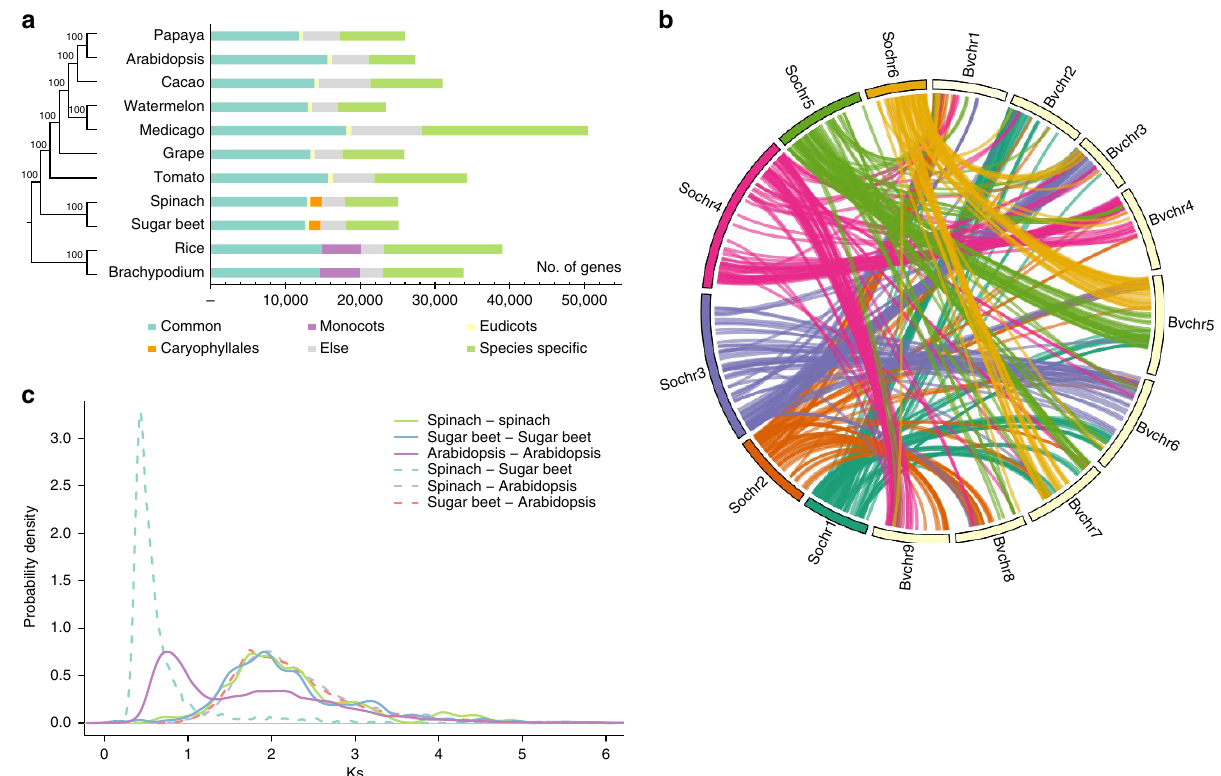
Figure 2 | Comparative genomic analysis among spinach and other plant species. ( a ) Phylogenetic relationship and gene clusters of 11 plant species. A maximum parsimony (MP) species tree (left) was constructed using protein sequences of the 2,047 single-copy genes. Bars (right) represent the number of genes in different categories for each species. Common: genes that are found in at least 10 of the 11 species. Monocots: genes that are only found in the two monocots, rice and Brachypodium ; Eudicots: genes that are found in at least eight of nine eudicots but not in the two monocots; Caryophyllales: genes that are only found in spinach and sugar beet; Species-specific: genes with no homologues in other species. ( b ) Syntenic relationships between spinach and sugar beet genomes. ( c ) Ks distribution of homologous gene pairs in spinach, sugar beet and Arabidopsis. The probability density of Ks was estimated using the ‘density’ function in